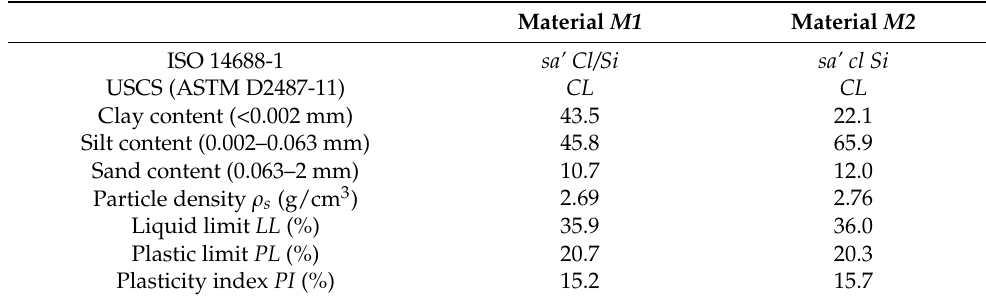
Figure 1. Particle size distribution of materials M1 and M2 . Table 1. Characterization of raw materials M1 and M2 with respect to their soil classification, particle size distribution, particle density and Atterberg limits.